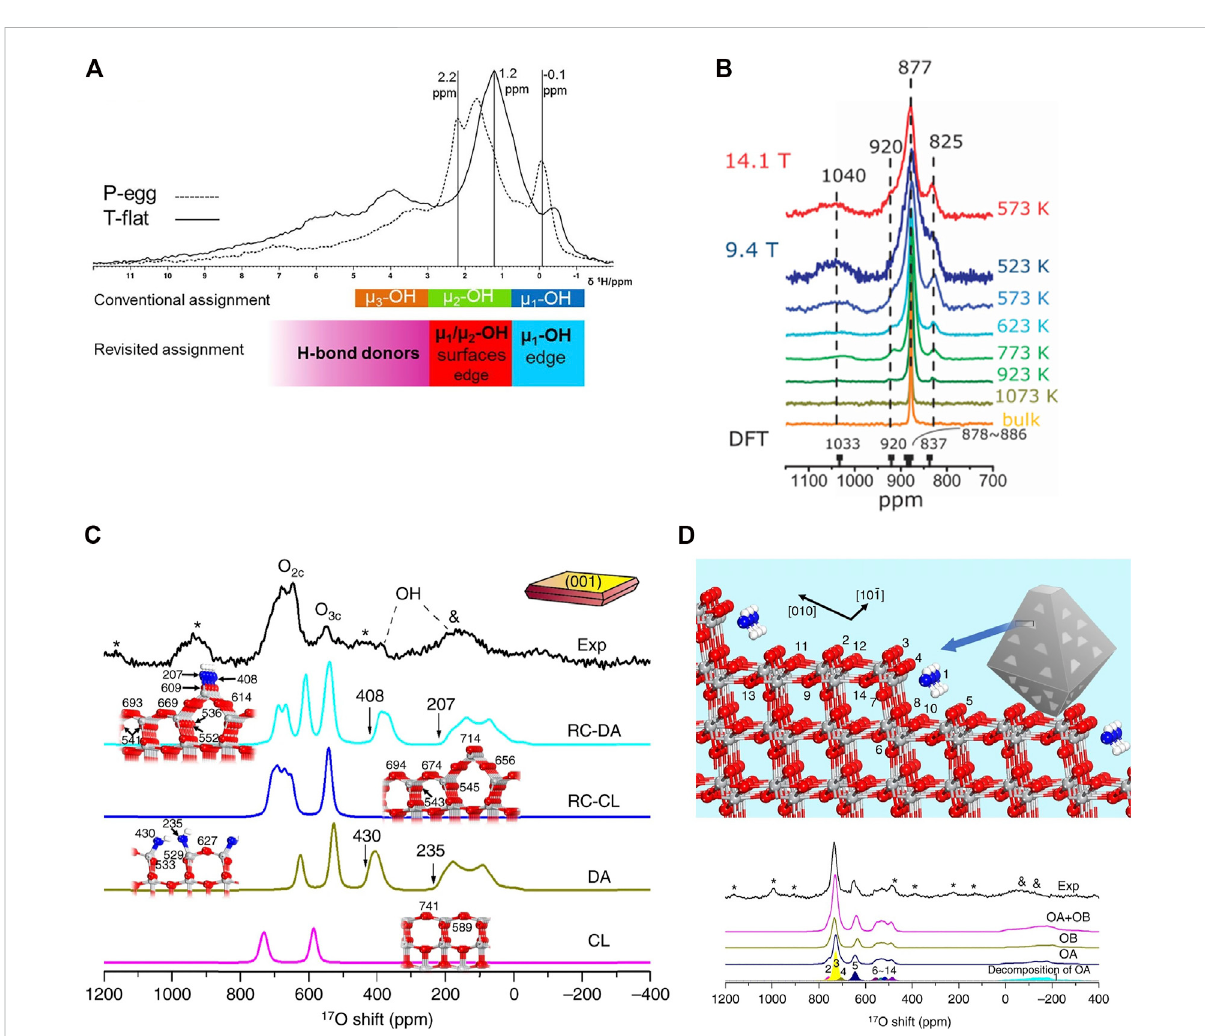
FIGURE 1 (A) 1 H MAS NMR spectra of two different aluminas showing conventional and revisited peak assignments. Reprinted with permission from ref (Batista et al., 2019) (with permission from Elsevier); (B) 17 O NMR spectra for ceria nanoparticles enriched at different temperatures and acquired at differentexternal fi eldscomparedwiththe 17 ONMRspectraofmicrometer-sizedceria(bulkceria). Reprintedfromopenaccessfromref (Wangetal., 2015) (C) Simulated and Experimental 17 O NMR spectra of isotopically labeled TiO 2 . Simulated TiO 2 is de fi ned as follows: un-reconstructed clean (001) anatase (CL), hydrated (001) anatase with ½ monolayer water coverage (DA), 1 × 4 — reconstructed clean (001) anatase (RC-CL),